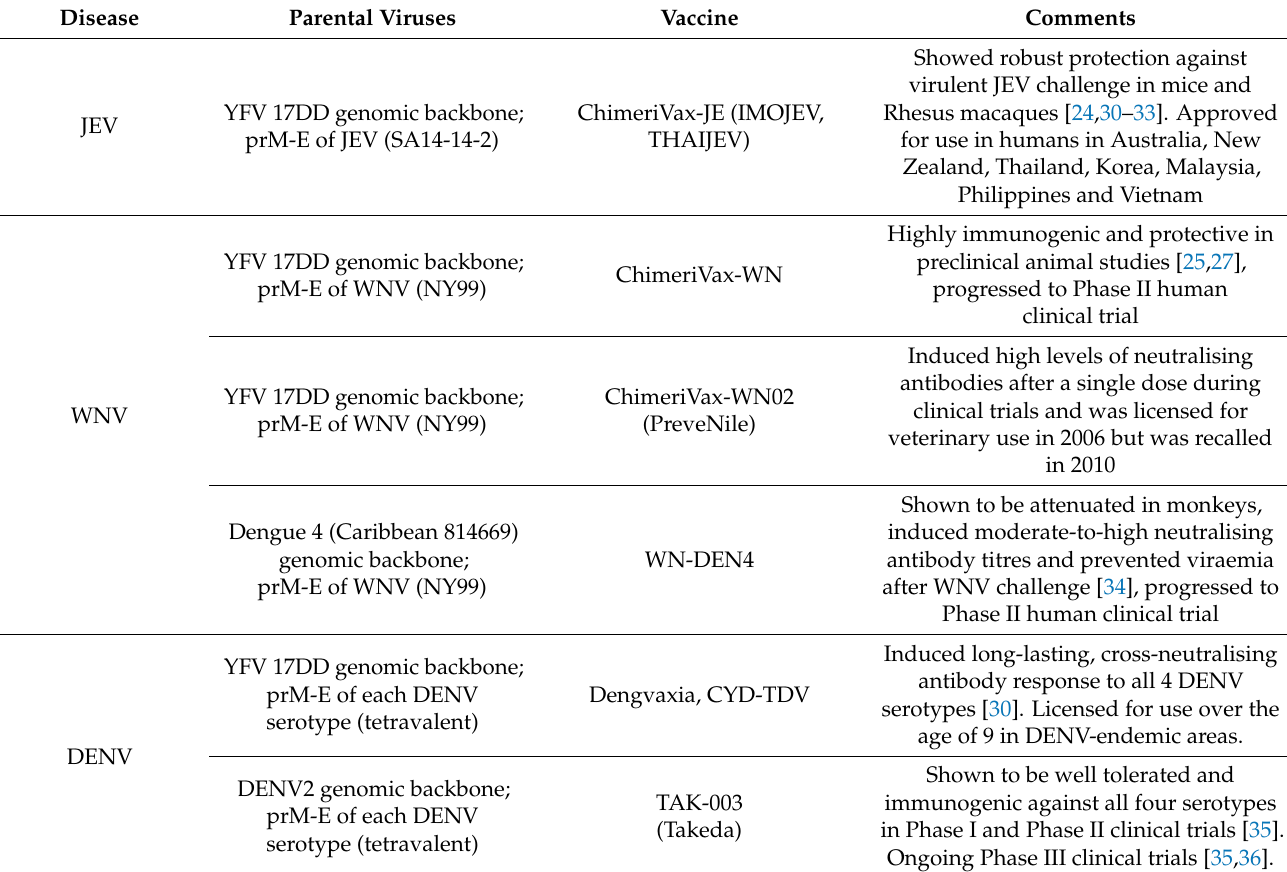
Table 2. Examples of genetically engineered live-attenuated